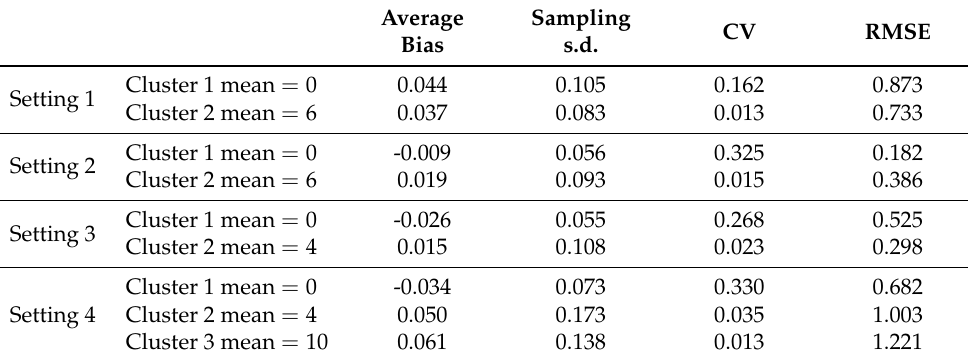
Table 1. Monte Carlo simulation results comparing the cluster analysis results from the resampled data to those of the sample data under four simulation settings, including average bias, sampling standard deviation (s.d.), coefficient of variation (CV), and root mean-square error of the estimation differences